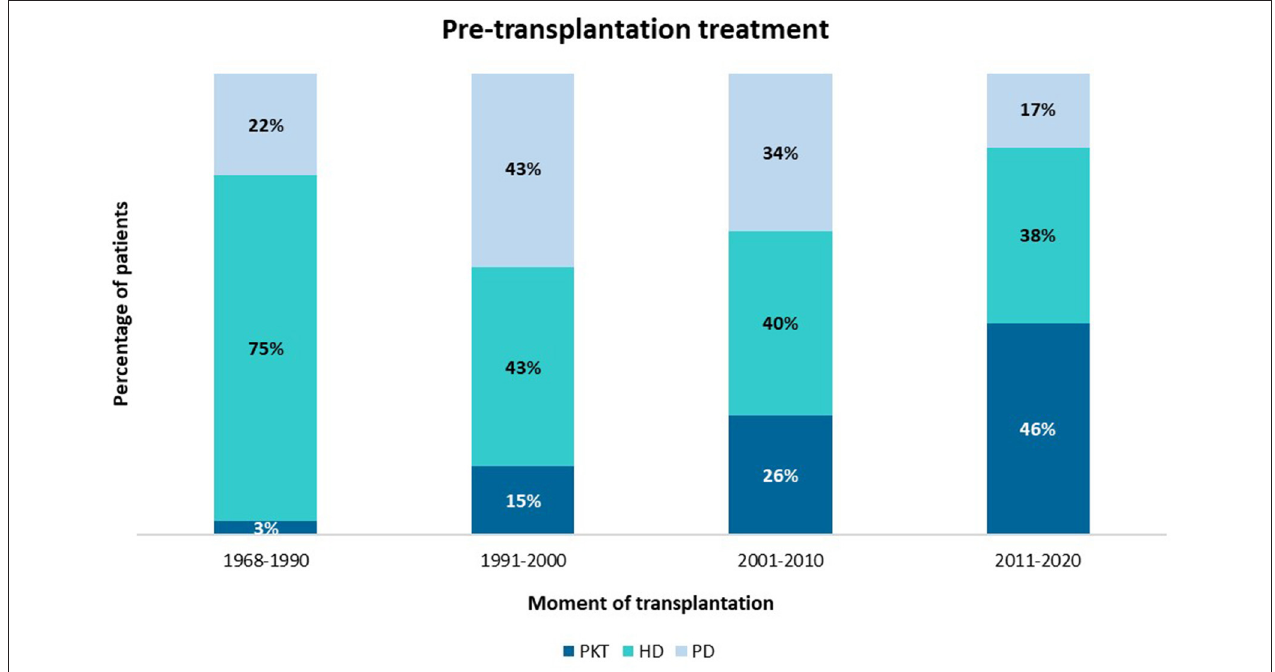
FIGURE 2 | Mode of pre-transplantation treatment per era of transplantation. PKT, pre-emptive kidney transplantation; HD, hemodialysis; PD. peritoneal